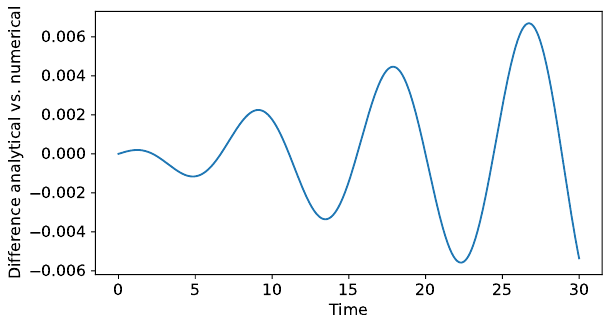
Fig. 104.— Difference between our numerical solution and the analytical solution